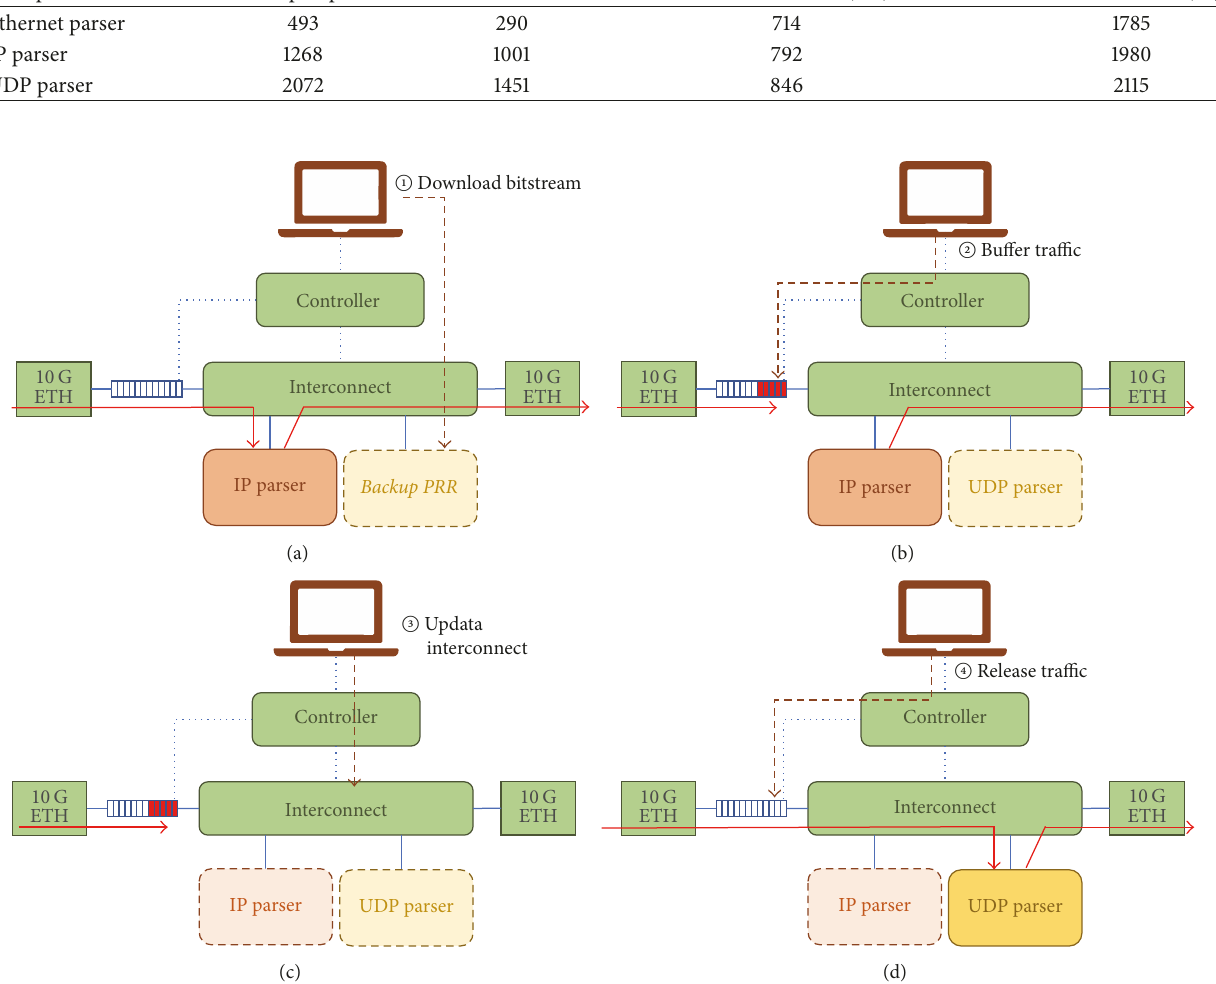
Figure 8: The proposed reconfiguration process that supports function reconfiguration in real time has the following four steps: (a) downloading partial bitstream to the backup PRR; (b) buffering the traffic; (c) updating the interconnect; (d) releasing the